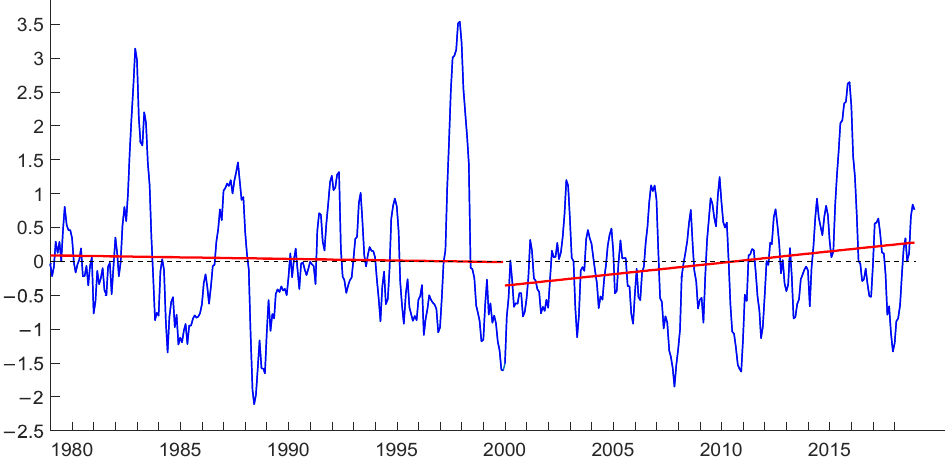
Figure 9. Equatorial SST averaged over the eastern Pacific Ocean (140° W–80° W, 5° S–5° N) during 1979–2018. Red lines denote the trend during the period 1979–1999 and the period 2000–2018.